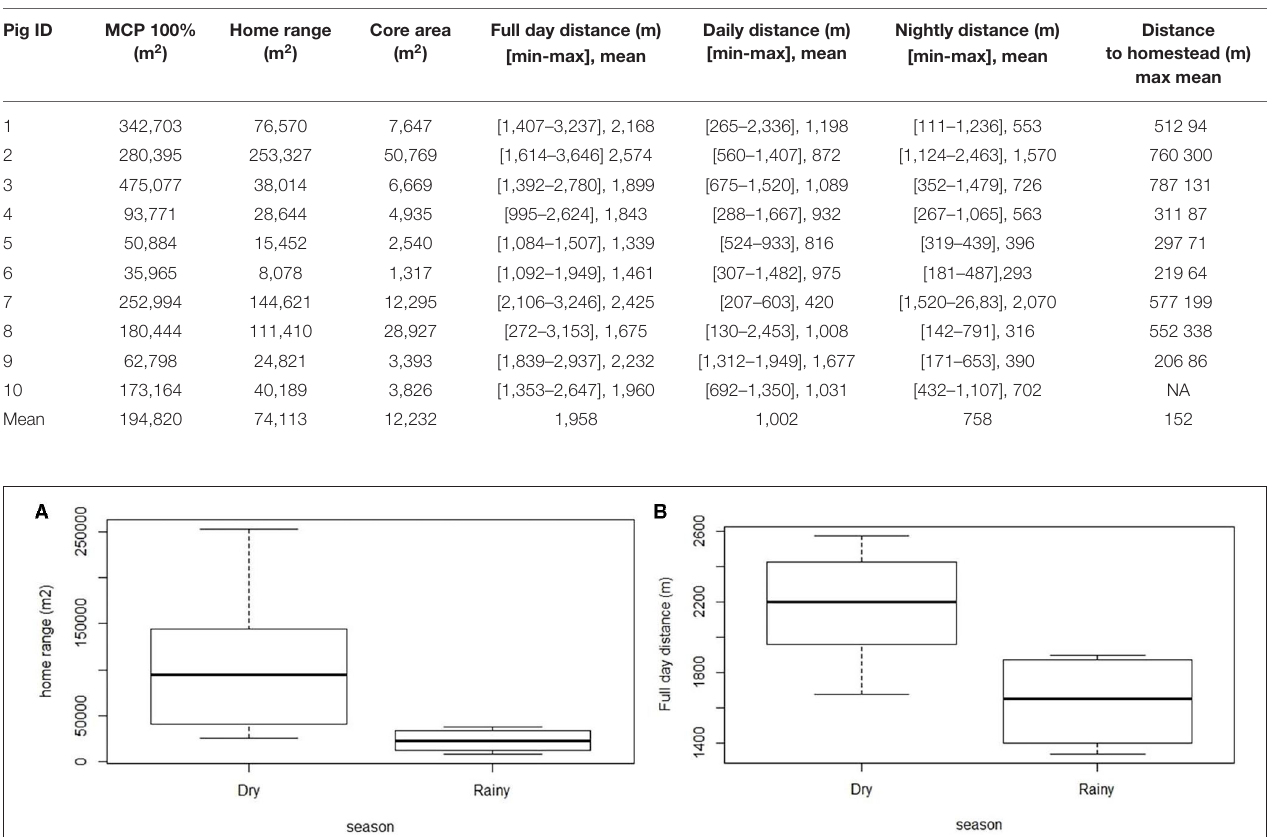
FIGURE 4 | Distribution of the home range (A) and the mean 24h distance (B) of the 10 monitored pigs according to the season. Intervals defining boxes represent the interquartile range (IQR), while intervals out of the boxes (whiskers) show the highest and lowest values within 1.5 × IQR.